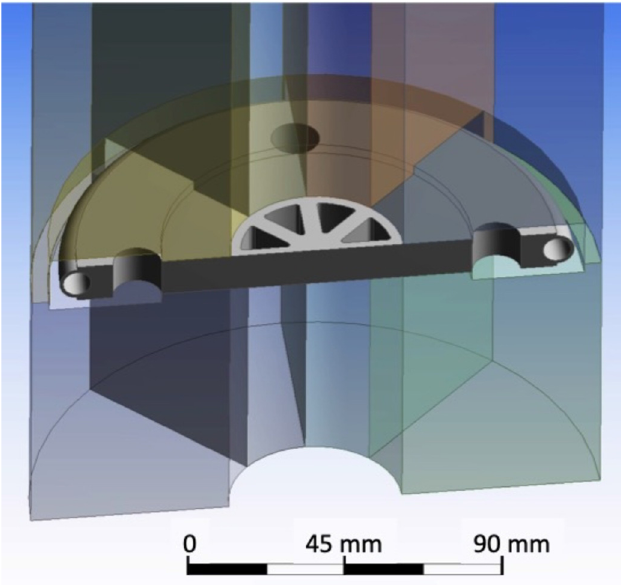
Fig. 9. New copper disk